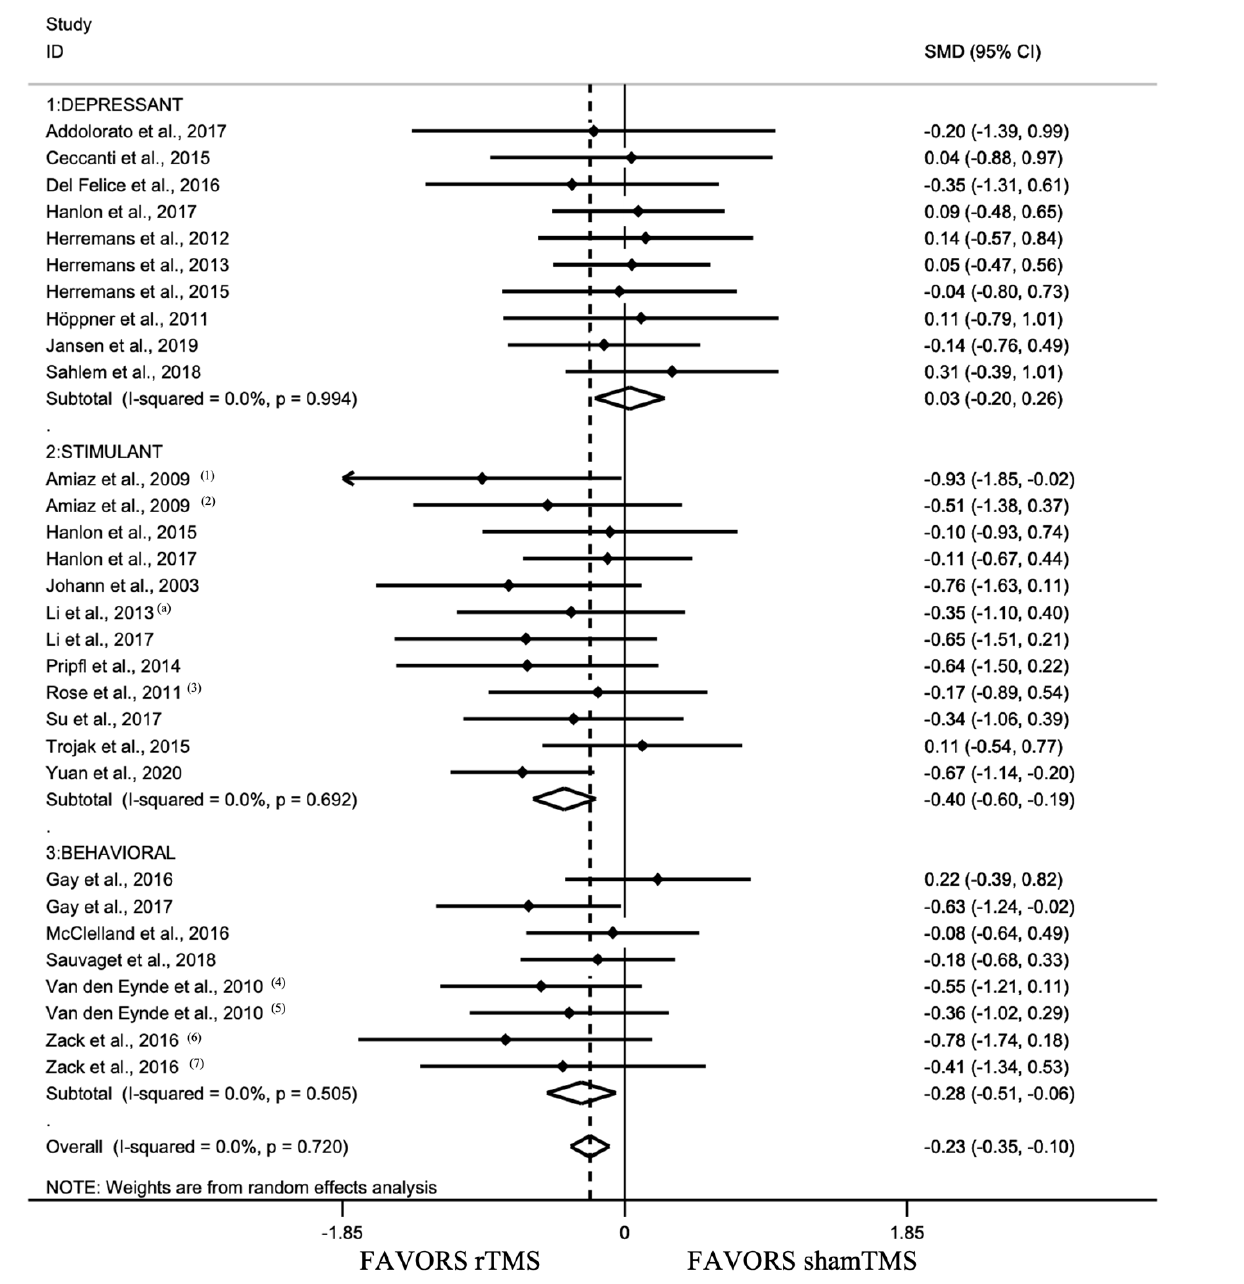
Figure 5. Forest plot for the subgroup analysis by addiction type’s group (depressant: alcohol, cannabis, opiate [81,82,91,92,94,98–101,107]; stimulant: nicotine, cocaine, methamphetamine [80,87,88,90,93,98,102–104,109,111]; and behavioral: eating disorder, gambling disorder [89,96,97,105,112,113]) using random effects model (without excluded studies, 30 units of analysis). Heterogeneity: Q = 24.18, df = 29, p = 0.72, I 2 = 0%. Test for overall effect: Hedge’s g = −0.228 (95% CI: −0.355, −0.102), z = 3.53, p < 0.001. (1), craving evaluated by Visual Analog Scale (VAS); (2), craving evaluated by sTCQ; (3), low frequency stimulation; (4), craving evaluated by VAS; (5), craving evaluated by FCQ-s; (6), high frequency MPFC stimulation; (7), low frequency right DLPFC stimulation; (a), [103].